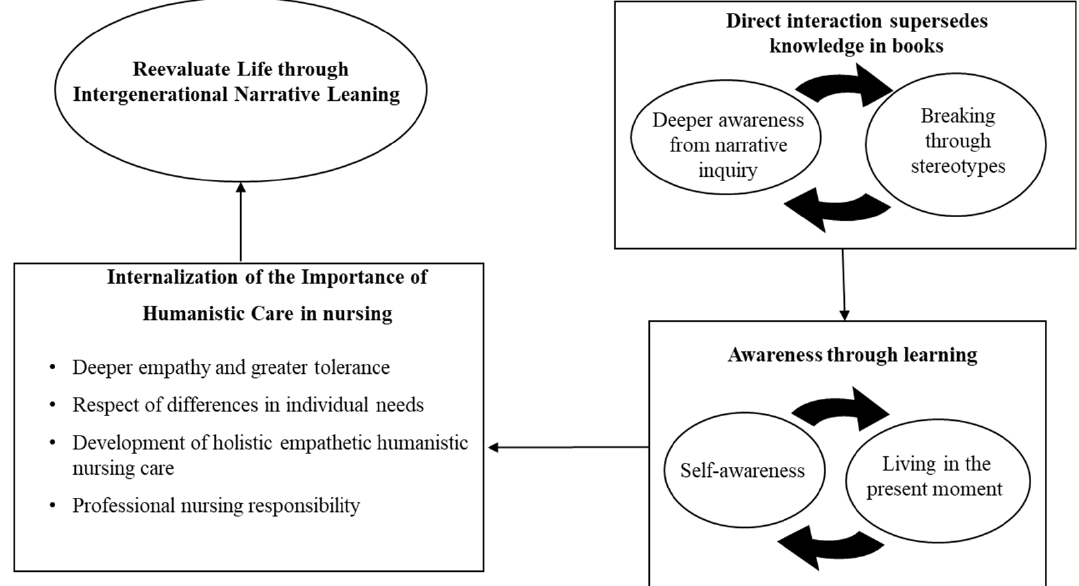
Figure 1. Structure of inspiration toward improved humanistic caring through intergenerational narrative learning (INL).